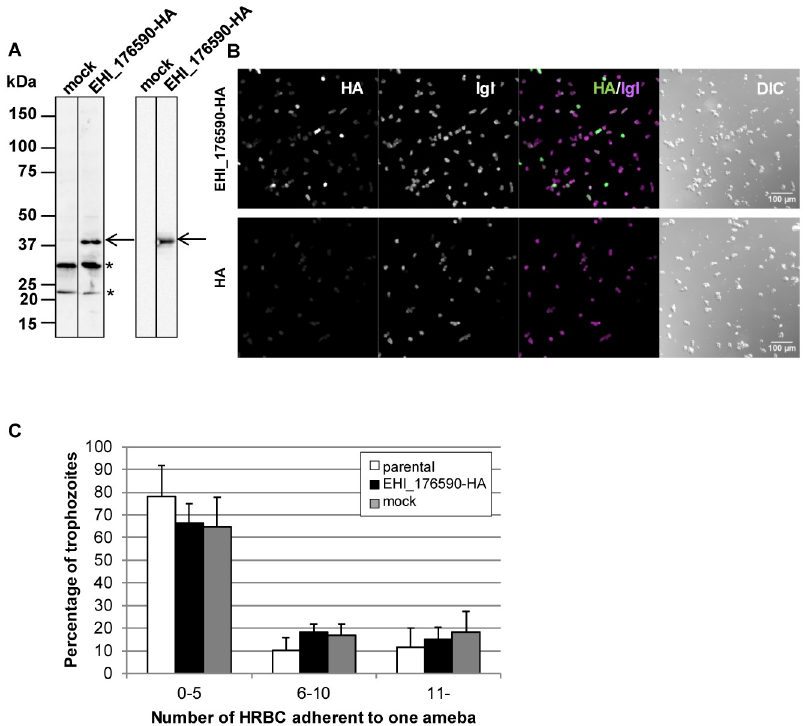
Fig 6. EHI_176590-HA expression in KU27 (A) Immuno-detection of EHI_176590-HA ectopically expressed in strain KU27. Total cell lysates, from mock-transfected and EHI_176590-HA-expressing strain KU27 trophozoites, were analyzed by immunoblot analysis with anti-EHI_176590 (left panel) and anti-HA antibody (right panel). The arrow indicates EHI_176590-HA, and asterisks indicate protein bands detected by non-specific immunoreactivity. (B) Low-magnification confocal immunofluorescence images of EHI_176590-HA-expressing and mock-transfected KU27. Trophozoites were fixed and reacted with anti-Igl and anti-HA antibodies. Merged fluorescent (IGL/HA) and DIC images are also shown. (C) Adhesion of the parental, EHI_176590-HA-expressing, and mock-transfected KU27 to HRBCs. Parental (open bars), EHI_176590-HA-expressing (black bars), and mock-transfected (gray bars) KU27 strains were co-cultured with HRBCs on ice for 30 min, and adherent HRBCs per ameba were counted. The total number of trophozoites was set to 100%, and the percentage of trophozoites, bound to 0–5, 6–10, or > 10 HRBCs, are shown. Error bars indicate standard deviations of four biological